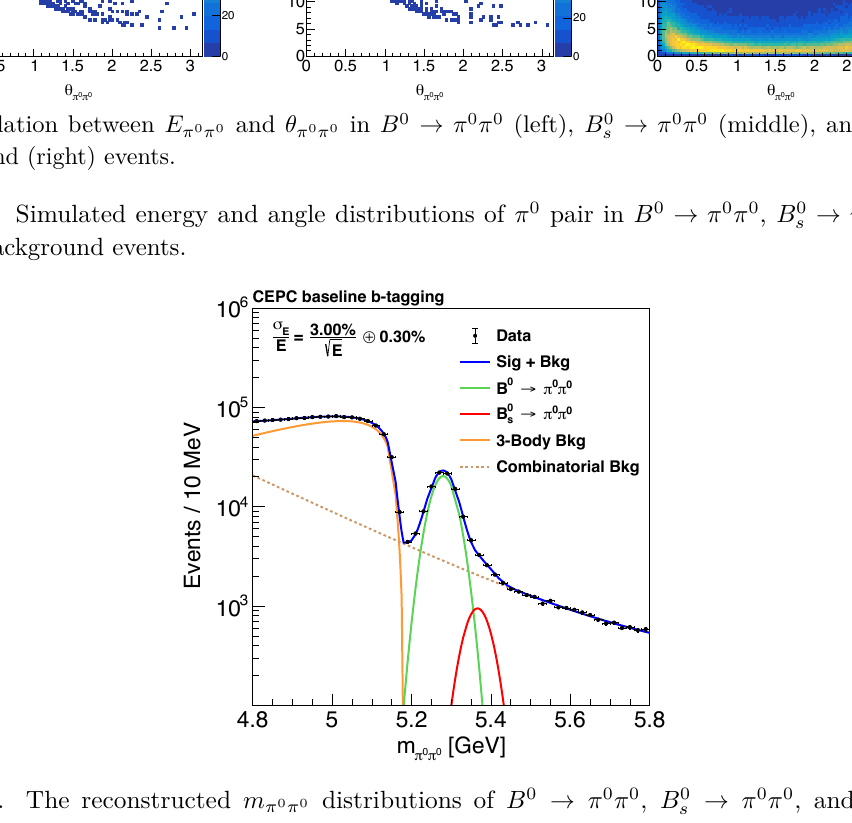
distributions of B 0 → π 0 π 0 , B 0 → π 0 π 0 , and Z → q ¯ q π 0 π 0 s ⊕ 0 . 3% E